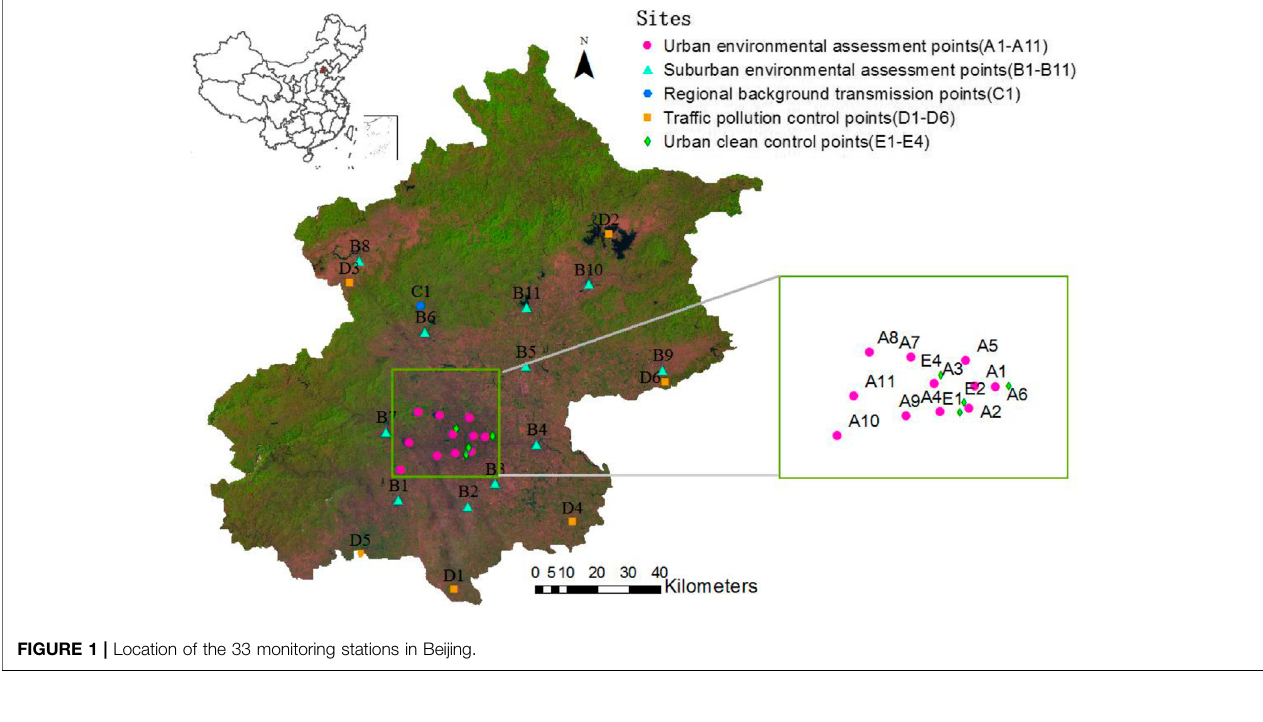
FIGURE 1 | Location of the 33 monitoring stations in Beijing.